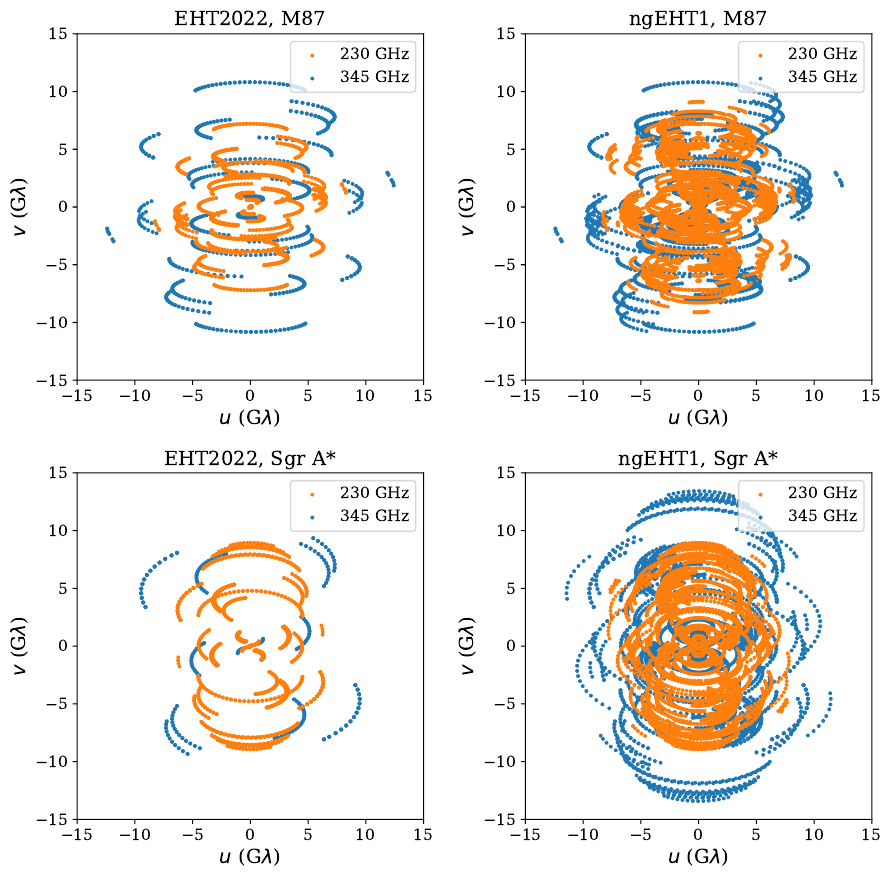
Figure 3. uv -coverage for the Challenge 1